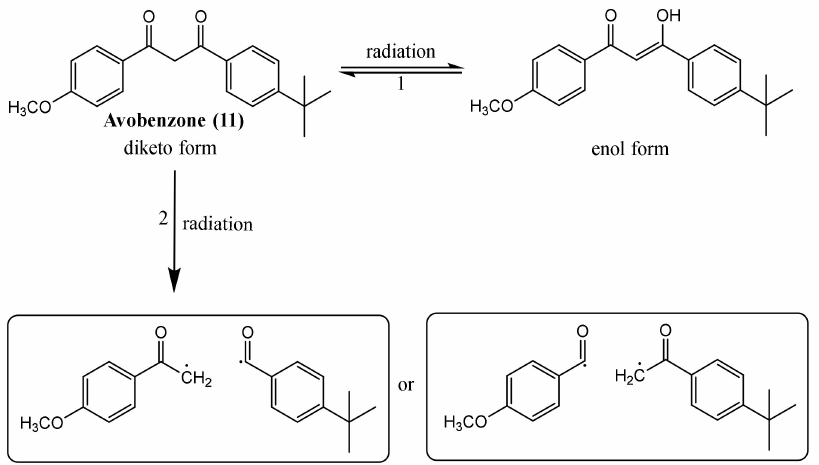
Figure 2. Mechanisms that could be triggered when avobenzone ( 11 ) is exposed to UV radiation, (1) photoisomerisation between di-keto and enol tautomers, or/and (2) formation of two radicals.